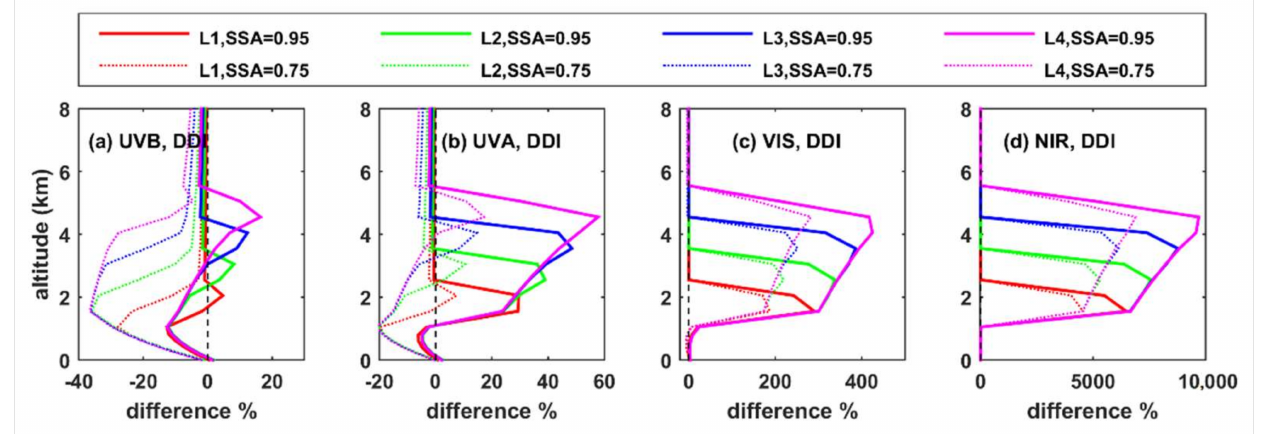
Figure 4. Change (in %) in the profiles of DDI in UVB, UVA, VIS, and NIR. The presented results are for AOD = 1, SZA = 60 ◦ , surface albedo = 0.1, TCWV = 1 g/cm 2 , and two values of the SSA: 0.75 (dotted lines) and 0.95 (solid